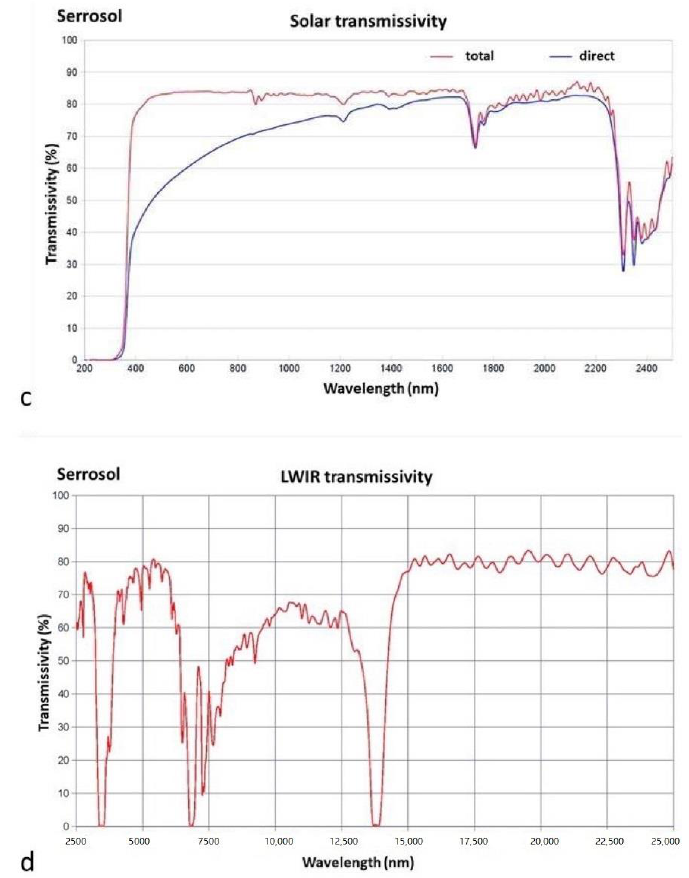
Figure 4. Total and direct spectral transmissivity to solar radiation (in the wavelength range 200–2500 nm) and to long infrared radiation (in the wavelength range 2500–25,000 nm) of cover C (Coverlys ® agrotextyle, ( a , b )) and cover S (Serrosol film ( c , d